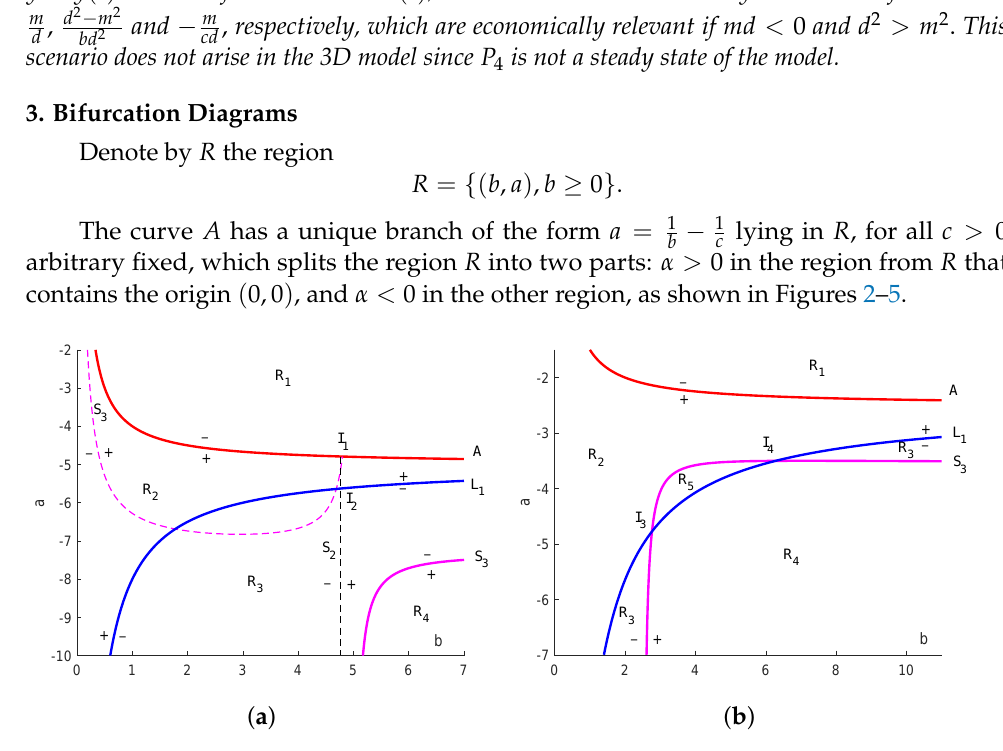
Figure 2. Bifurcation diagrams of the system (3) for 0 < c < 1 and ( a ) 0 < m < c 0 d , respectively,